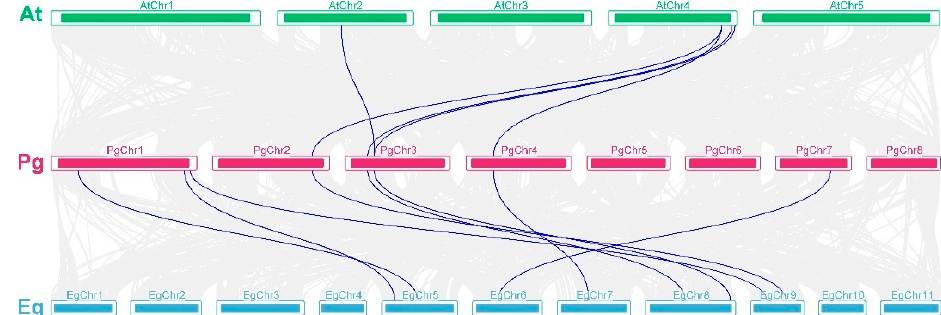
Figure 3. Genome-wide synteny analysis for CAD genes among P. granatum , E. grandis , and A. thaliana . The blue lines indicate ortholgs gene pairs. Eg, E. grandis ; Pg, P. granatum ; At, A. thaliana . There were five different kinds of duplication events in genes: whole genome duplica- tion or segmental (WGD), tandem duplication (TD), dispersed duplication (DSD), proximal Table 3. The four duplicated types of PgCADs . duplication (PD), and singleton duplication (SD). We found four of these in PgCADs and no SD events (Table 3). TD (36%) accounted for the majority of CAD genes, followed by WGD (20%) and DSD (20%); PD (12%) was the least. In Chr3, which had a large number